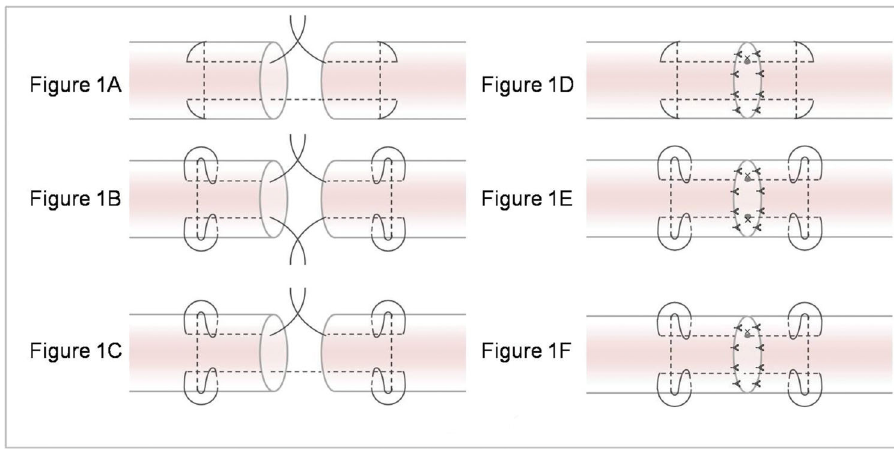
Figure 1 - Various suture techniques used for mechanical testing. (A) Modified Kessler suture without epitendinous suture (MK); (B) double knot Kessler-loop lock flexor tendon suture without epitendinous suture (DK); (C) single knot Kessler-loop lock flexor tendon suture without epitendinous suture (SK); (D) Modified Kessler suture with epitendinous suture (MK + P); (E) double knot Kessler-loop lock flexor tendon suture with epitendinous suture (DK + P); (F) single knot Kessler-loop lock flexor tendon suture with epitendinous suture (SK +